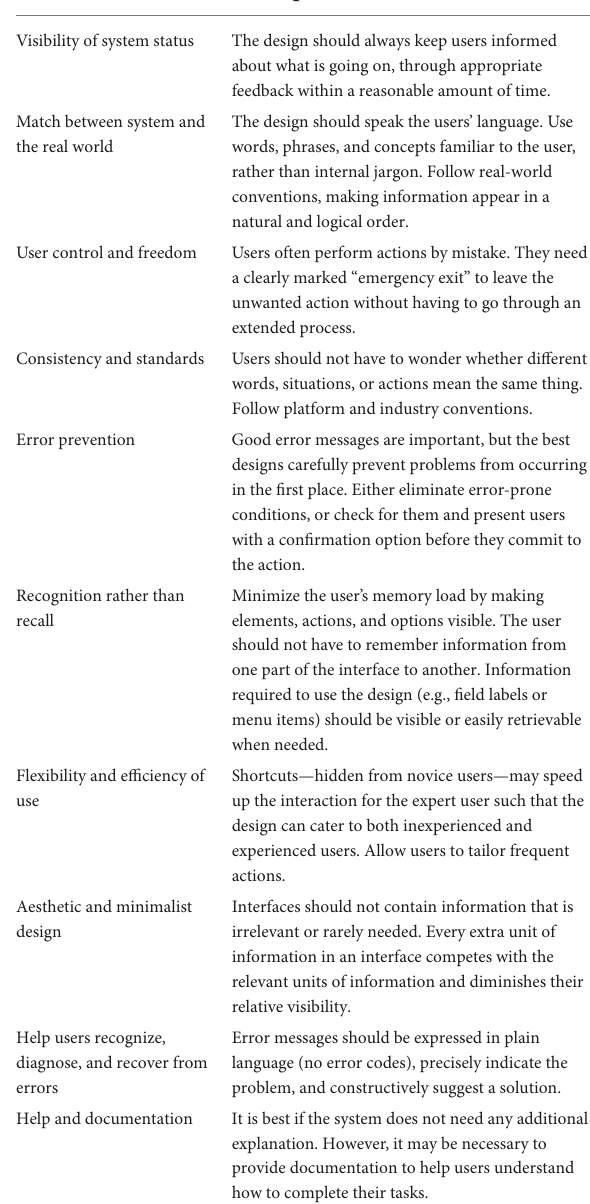
TABLE 4 Activity steps for thematic analysis. TABLE 5 Usability heuristics (Nielsen and Mack,